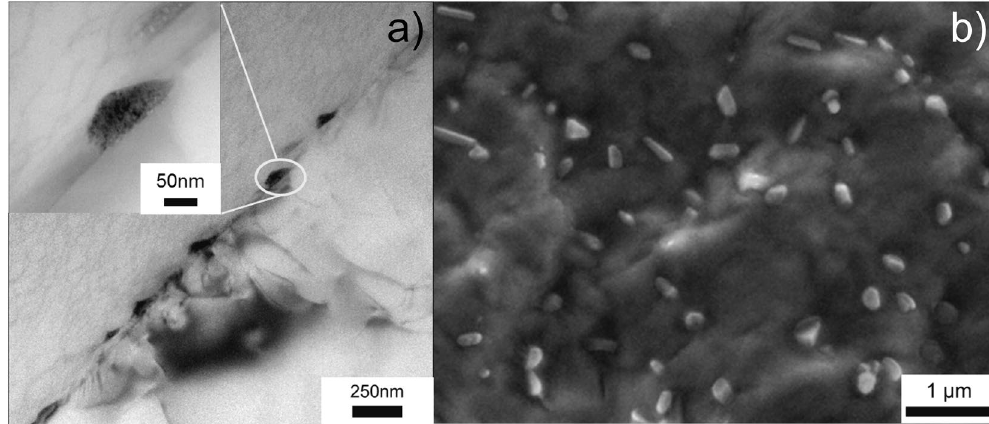
Figure 3. ( a ) TEM image of β -phase precipitates decorating the grain boundary of AA5083 sensitised at 100 °C for 30 days, and ( b ) HR-SEM image revealing the same β -phase from a Ga-embrittled fracture surface of the same specimen from the image in ( a ).